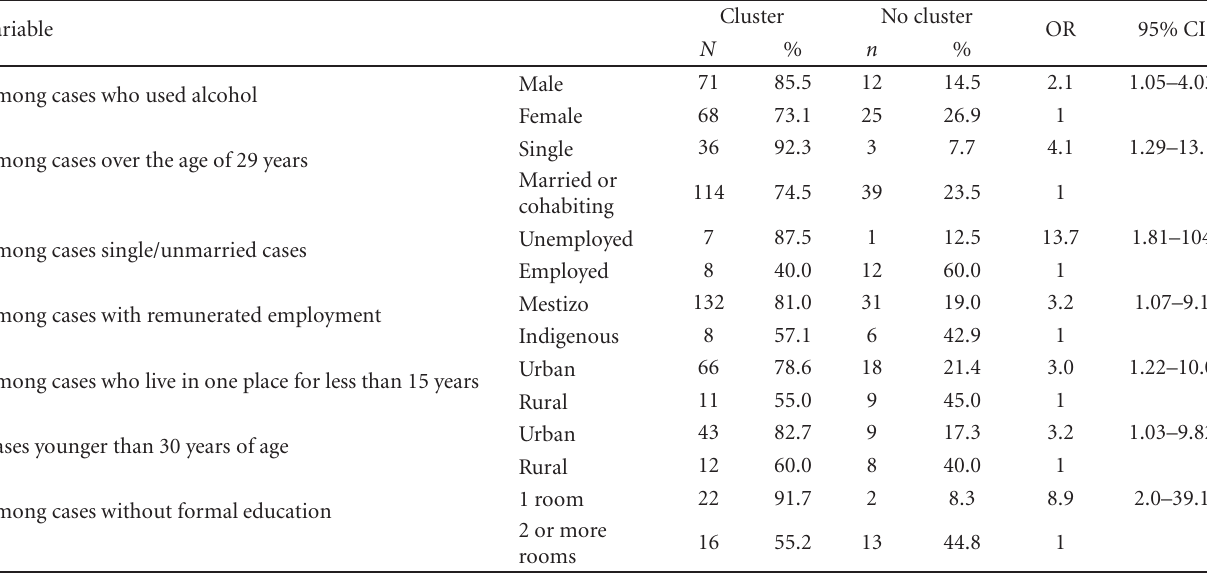
Table 6: Bivariate analysis of risk profiles associated with